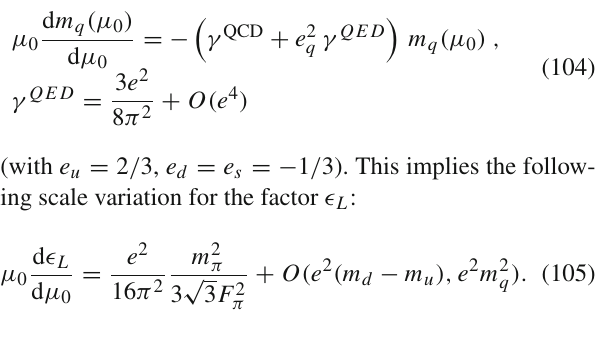
Table 3 Relative variation of the Dalitz plot parameters from their central values. Second column: the ηπ T -matrix elements are set to zero, third column: the ηπ T -matrix has larger phase shifts: